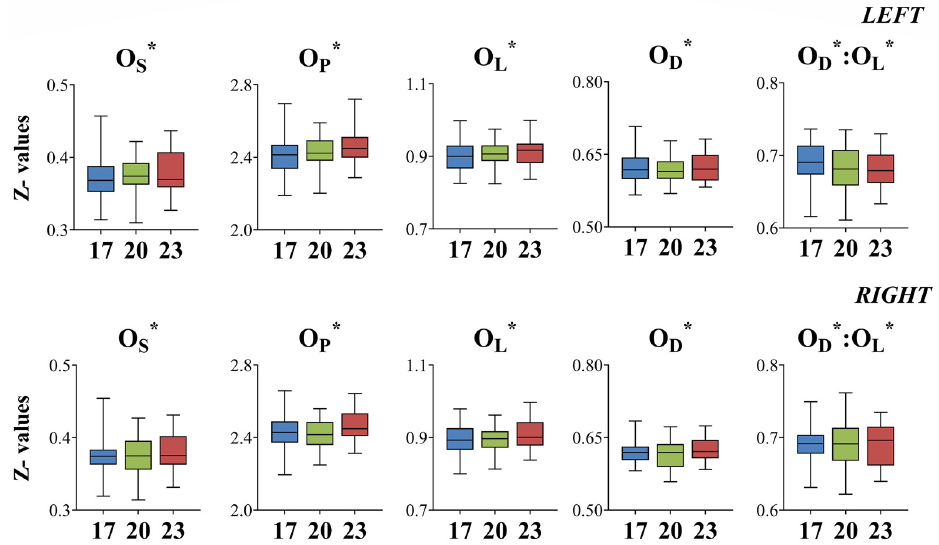
Figure 7. Box plots (—, median; (cid:3) , 25 and 75% percentiles; I, highest and lowest values) of stan- dardized univariate morphological descriptors (Z-values) for seabream metamorphosing larvae taken at 56–58 dph (days post-hatching); 17, 20, and 23: fish initially reared at 17, 20, and 23 ◦ C DT (developmental temperature), respectively. O L : maximum otolith length, O D : maximum otolith depth , O S : otolith surface area, O P : otolith perimeter.